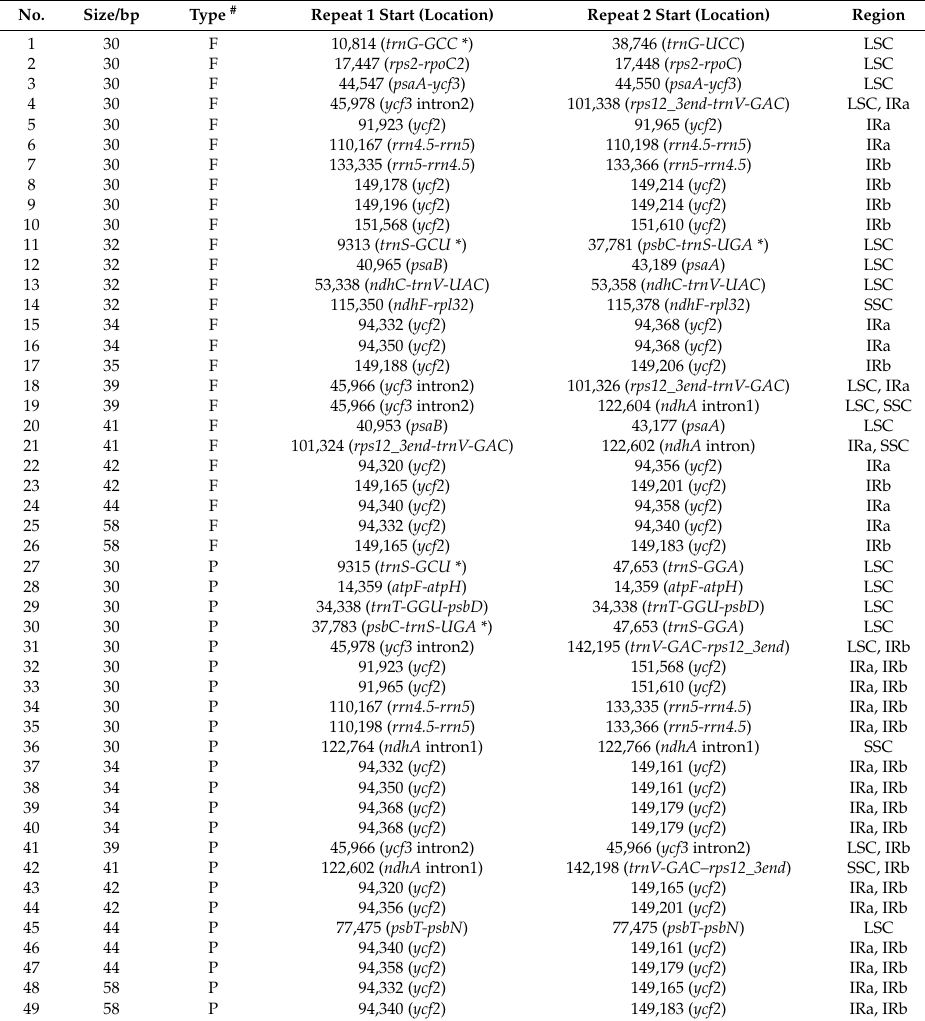
Table 4. Repetitive sequences of Forsythia suspensa calculated using